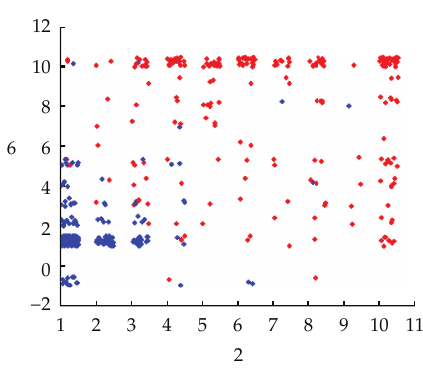
Figure 9: Wisconsin breast cancer data with perturbation. Attributes 2 and